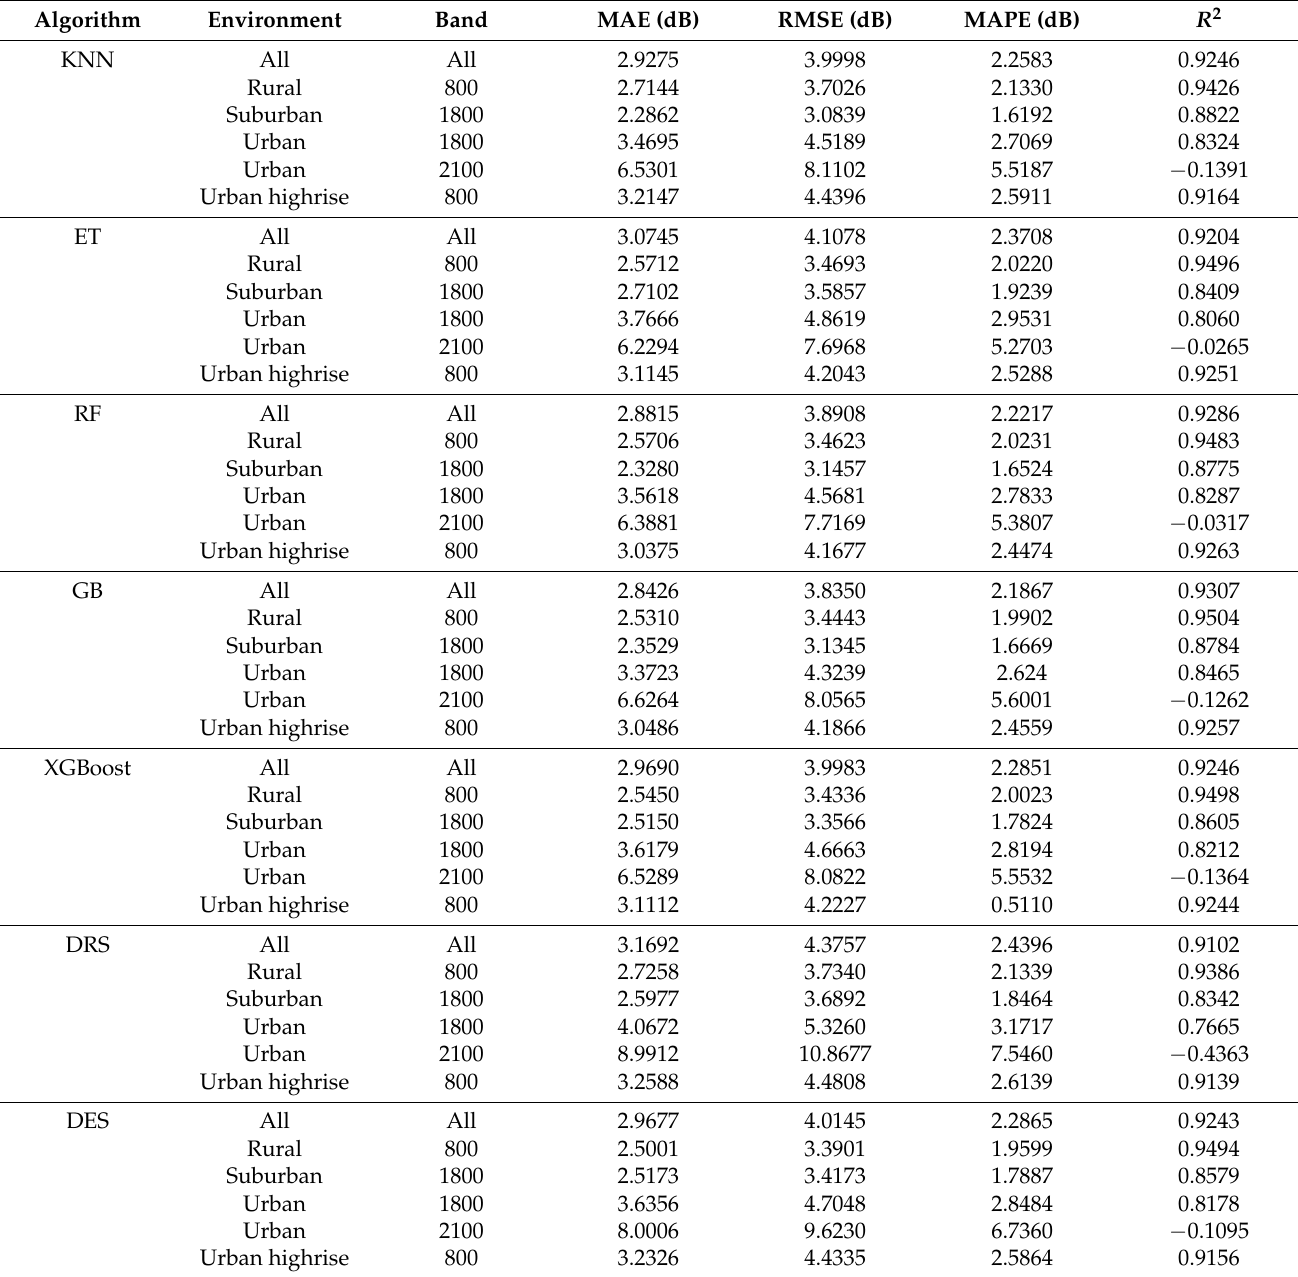
Table 4. Performance on the different cases in dataset